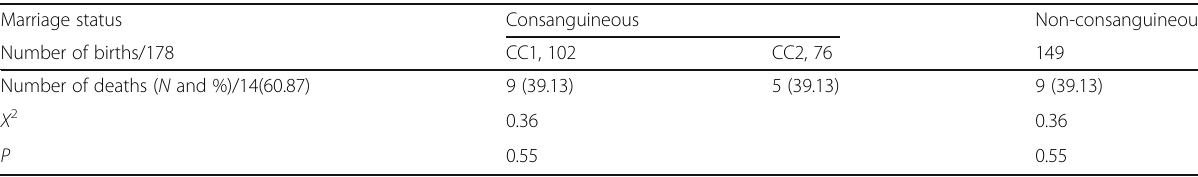
Table 4 Effect of consanguinity on